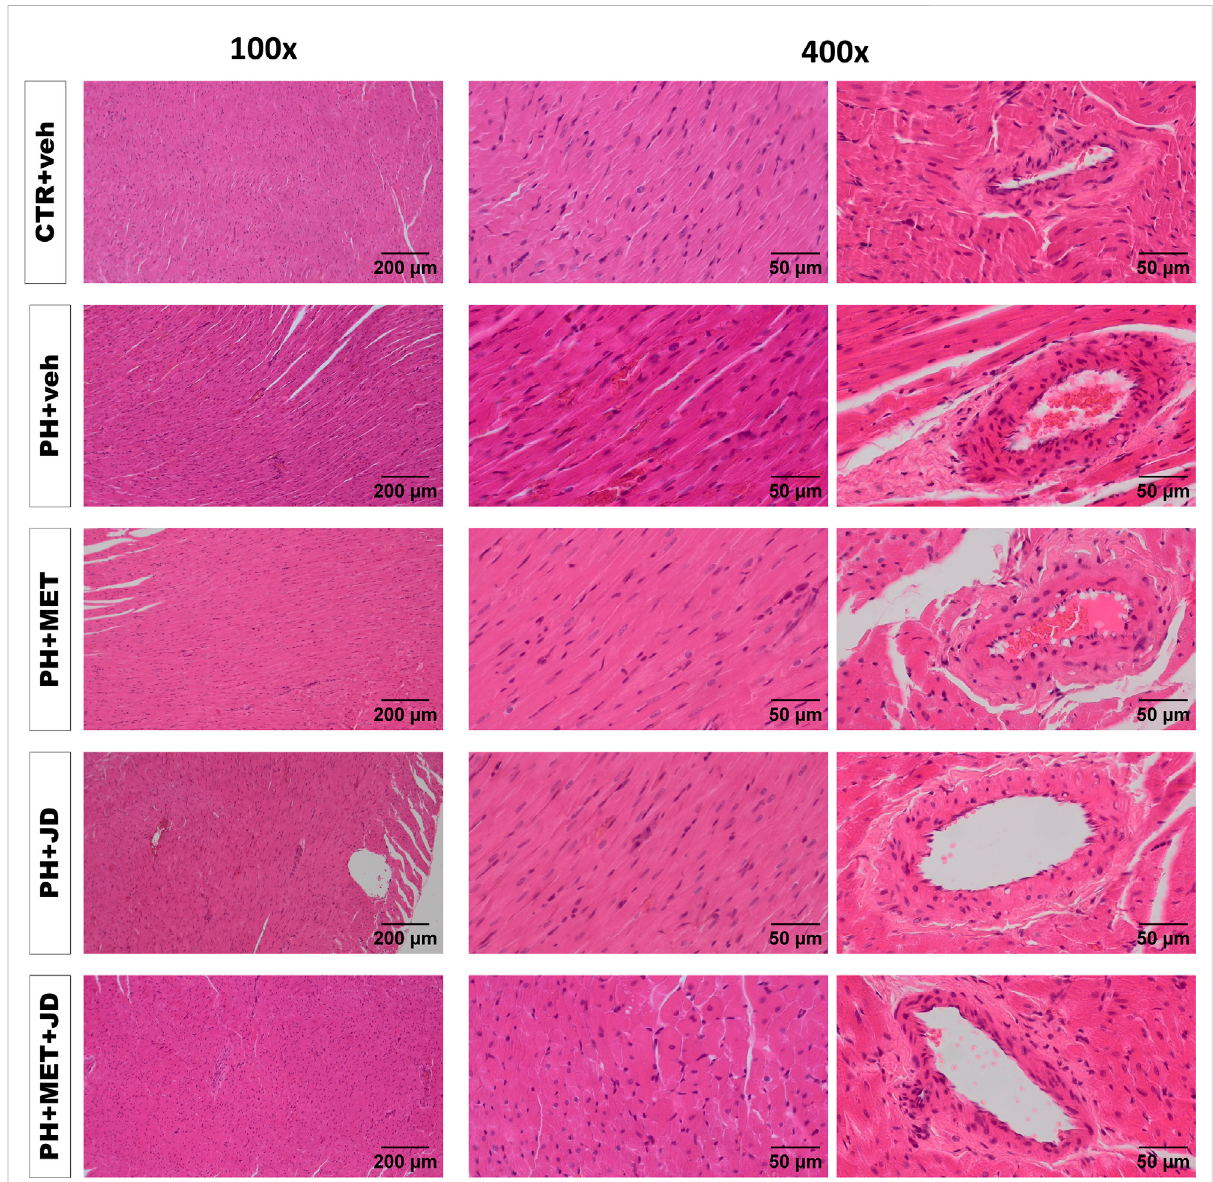
FIGURE 2 In fl uence of pulmonary hypertension, metformin (MET), JD5037 (JD) and/or their combination on right ventricular remodeling in monocrotaline-induced pulmonary hypertensive (PH) rats and their normotensive controls (CTR). Representative hematoxylin and eosin-stained right ventricle images (100x and 400x magni fi cation); quantitative evaluation is provided in Table 2. MET (100 mg/kg), JD5037 (3 mg/kg) or their combination were administered by oral gavage once daily for 21 days; controls received vehicles (veh)